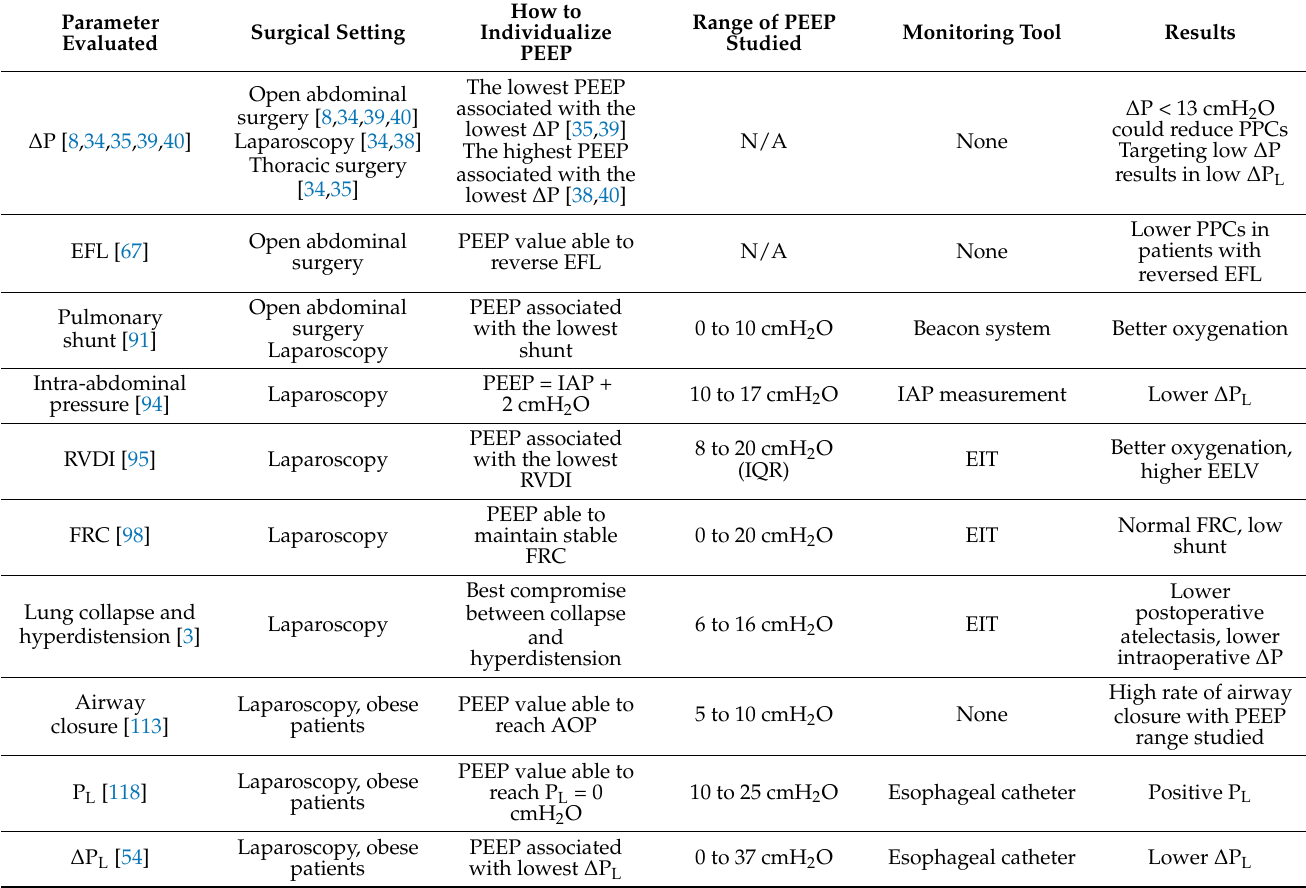
Table 1. Physiological parameters used to individualize positive end-expiratory